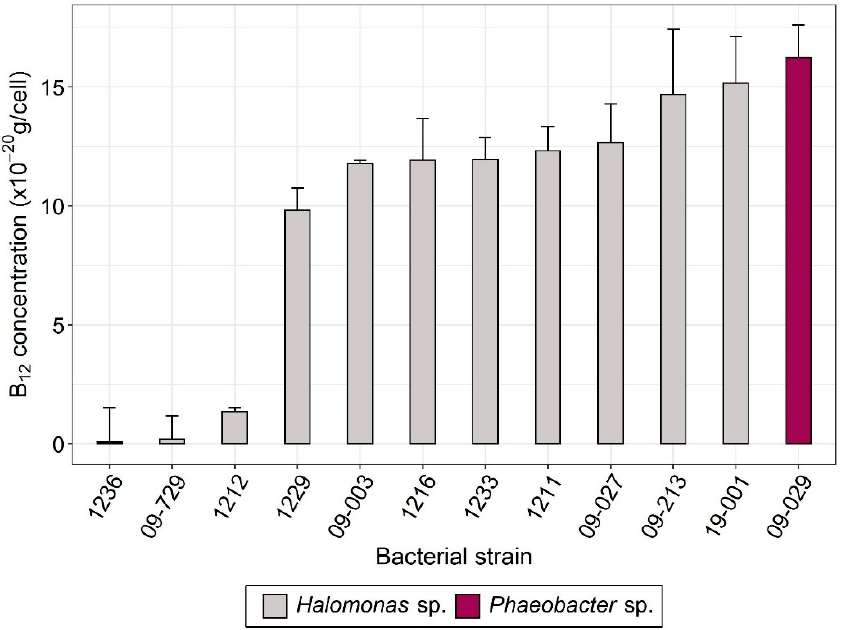
Figure 1. Screening of 12 bacterial strains for vitamin B 12 content (means of n = 9 technical replicates ± standard deviation of the mean). The genus of the isolates is indicated.